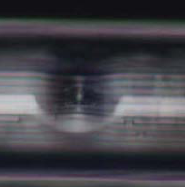
inscribed in microstructured optical (MOF) filled with ferrofluid [81].